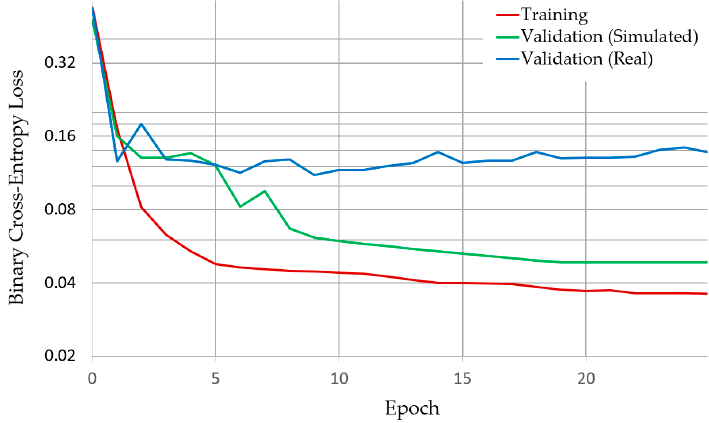
Figure 5. Training graph and two validation graphs for a validation dataset consisting of real and simulated defects respectively, plotted over the course of training.